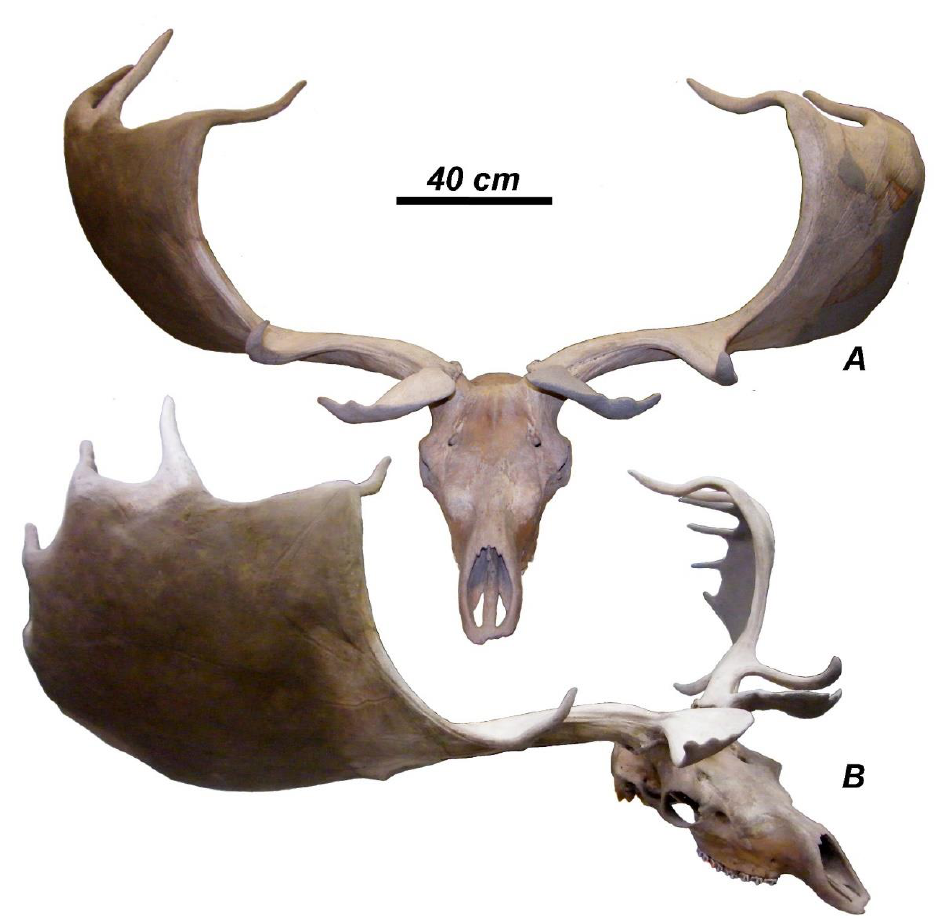
Figure 7. The antlered skull of Megaloceros giganteus ruffii (Nehring, 1891) from the Rhine Valley, Germany (Nr. 6517.5.9.73.4, MNHS). The distal portions of antlers are partially reconstructed. Germany (Nr. 6517.5.9.73.4, MNHS): ( A ), frontal view; ( B ), oblique view. The distal portions of antlers are partially